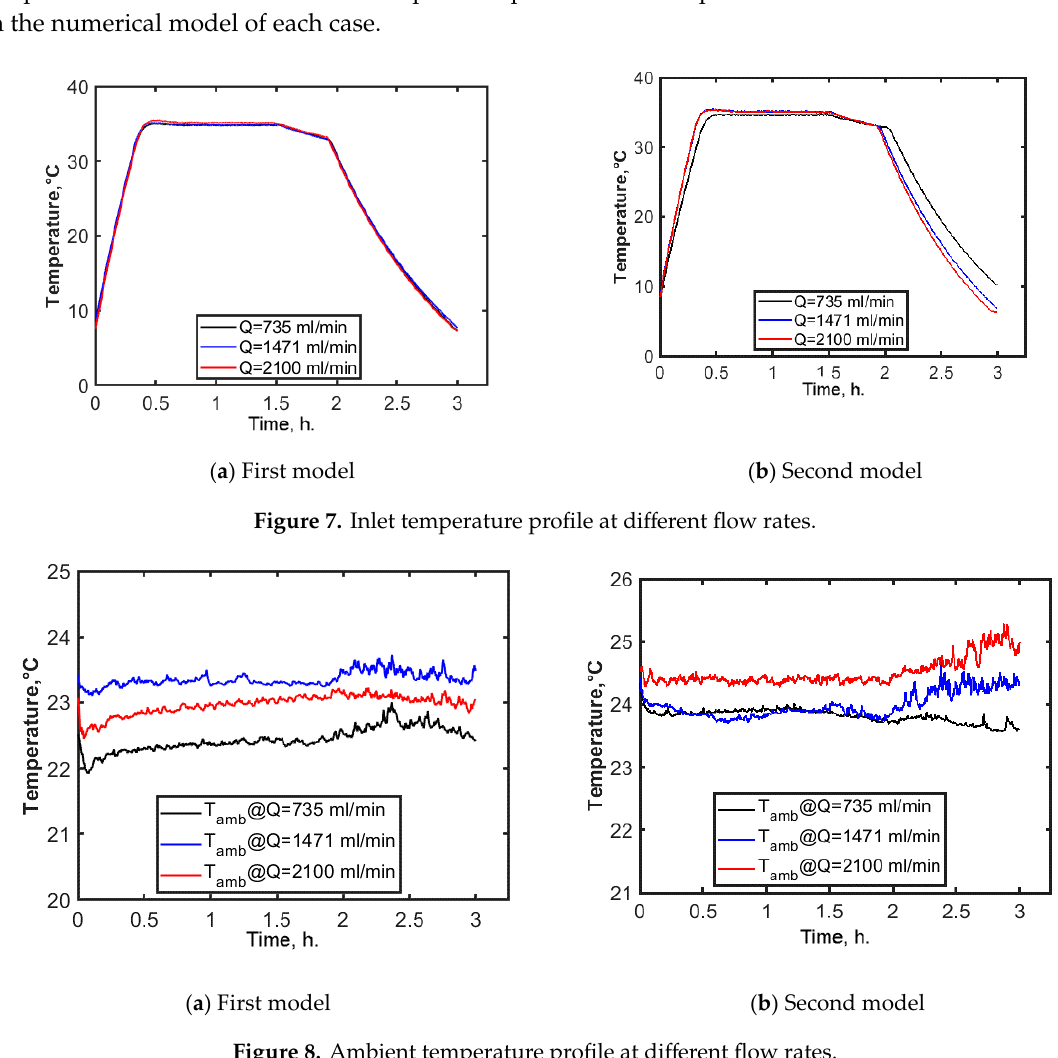
Figure 8. Ambient temperature profile at different flow rates.